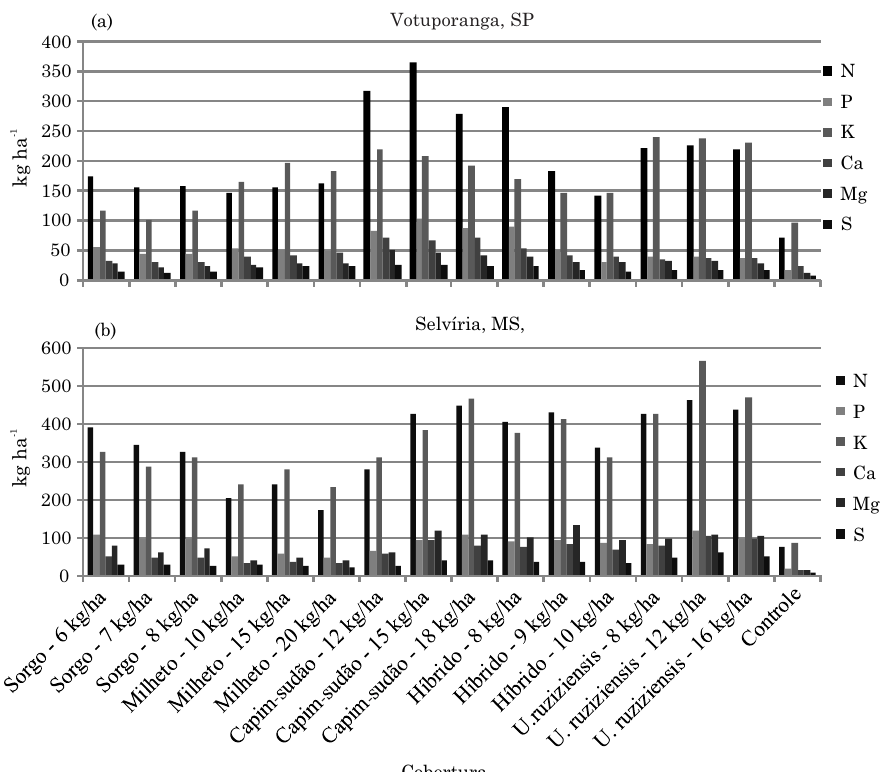
Figura 2. Teores médios de nitrogênio, fósforo, potássio, cálcio, magnésio e enxofre acumulados pelas plantas de cobertura, nas duas localidades avaliadas, em